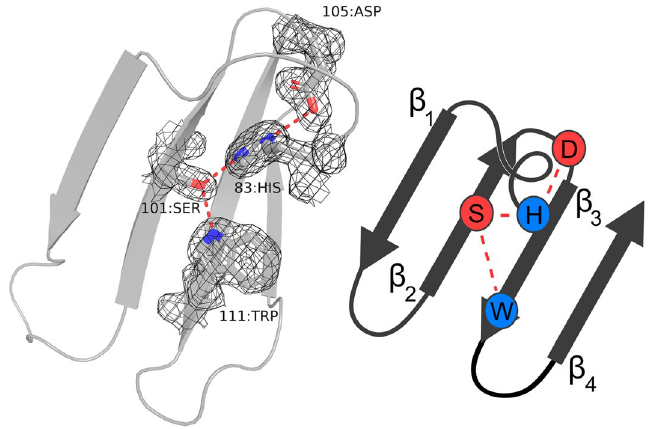
Figure 4. The hydrogen bonding network in WD40 repeats. A single repeat from the crystal structure nvWRAP-T showing the highly conserved hydrogen bonding network between 111:Trp, 101:Ser, 83:His and 105:Asp. The electron density is shown as a F c − F o map at sigma level 1. Beside the structure a diagram indicating the hydrogen network is shown. This figure was created with PyMOL 23